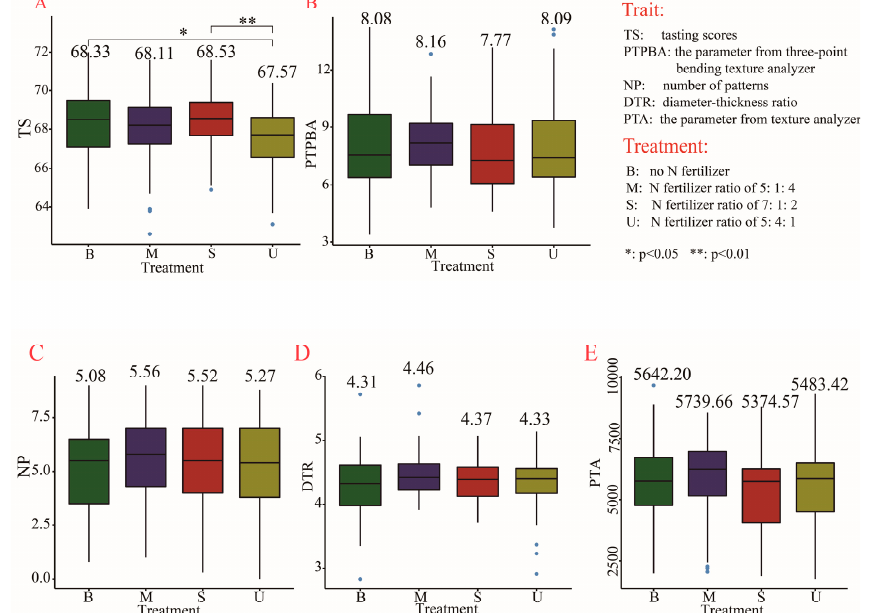
Figure 2. Quality evaluation of Chinese crisp biscuits and American cookies under four fertilizer treatments. ( A – E ) Comparison among four fertilizer treatments in tasting score ( A ); the parameter from three-point bending texture analyzer ( B ); the number of patterns ( C ); diameter–thickness ratio; ( D ) and the parameter from texture analyzer ( E ). Box diagrams present the data in the inter-quartile ranges. The lines across the boxes, whiskers, and blue circles denote the median values, the 10th and 90th percentiles and outliers, respectively. The number above the box represents the average level of the trait in each